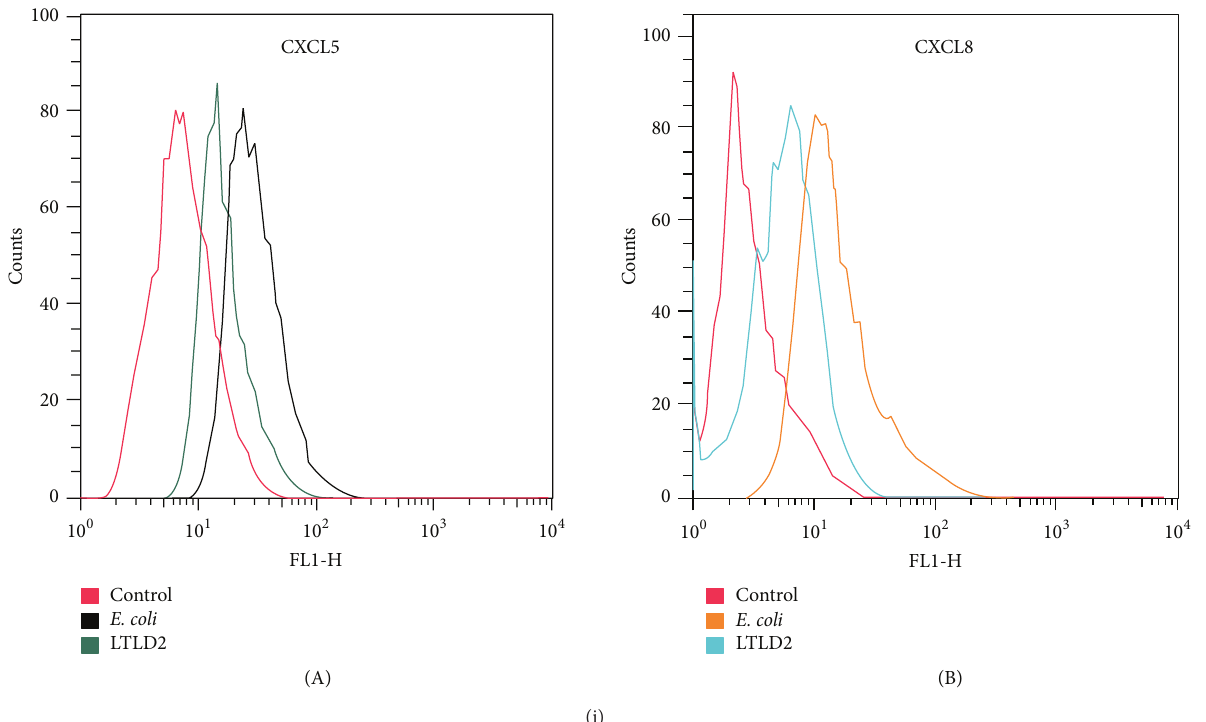
Figure 6: Effects of LTL on heat-killed E. coli induced inflammatory cell accumulation in BALF. BALF was prepared from mice 12h after heat-killed E. coli O18:K1, 10 4 CFU challenge with the induction of LTL at doses LTLD1 (25 mg/kg) and LTLD2 (50mg/kg). Total cell counts (a), number of macrophages (b), neutrophils (c), and total protein (d) in BALF samples. LTLD1 and LTLD2 reduced the elevated level of inflammatory cytokines in BALF of E. coli challenged mice. BALF was collected at 12h following E. coli challenge to assess the inflammatory cytokines such as TNF- 𝛼 (e), IL-1 𝛽 (f), IL-6 (g), and IL-10 (h) by ELISA and the chemokines CXCL5 and CXCL8 (i) by flow cytometry. Data are shown as means ± S.E.M. ( ∗ 𝑃 < 0.05 , ∗∗ 𝑃 < 0.01